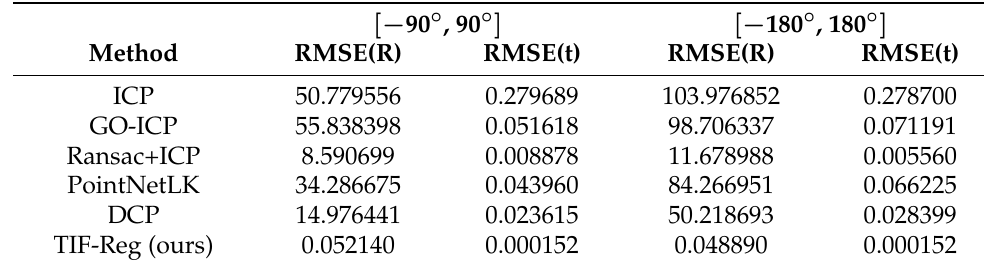
Table 3. Testing rotation robustness with translation within [ − 0.5 m, 0.5 m ] .